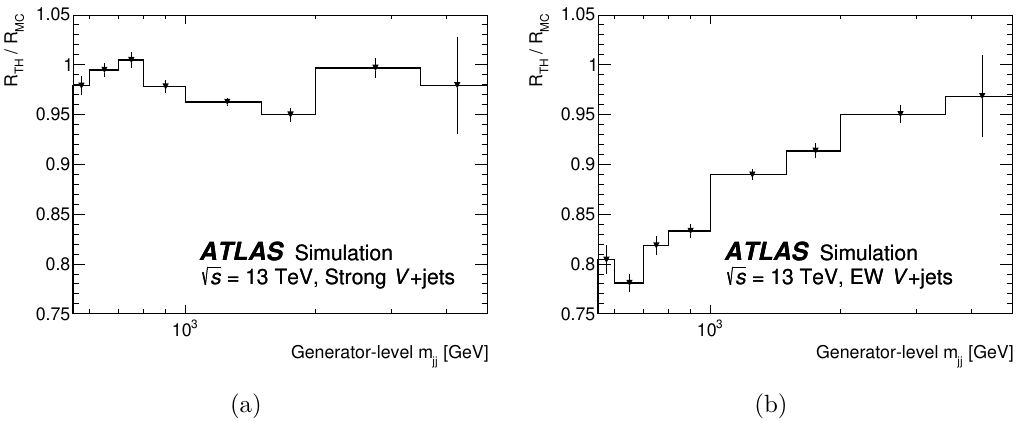
(cid:14) as a function of generator-level m , which is used to Figure 6. The double ratio R Z/W R Z/W jj TH MC correct the (a) strong and (b) electroweak V + jets simulation to achieve state-of-the art precision for the ratio of Z + jets to W + jets cross sections in the phase-space of a VBF-like signature as detailed in Reference [41], which is similar to the kinematic region targeted by the analysis. The error bars show the statistical uncertainty of the